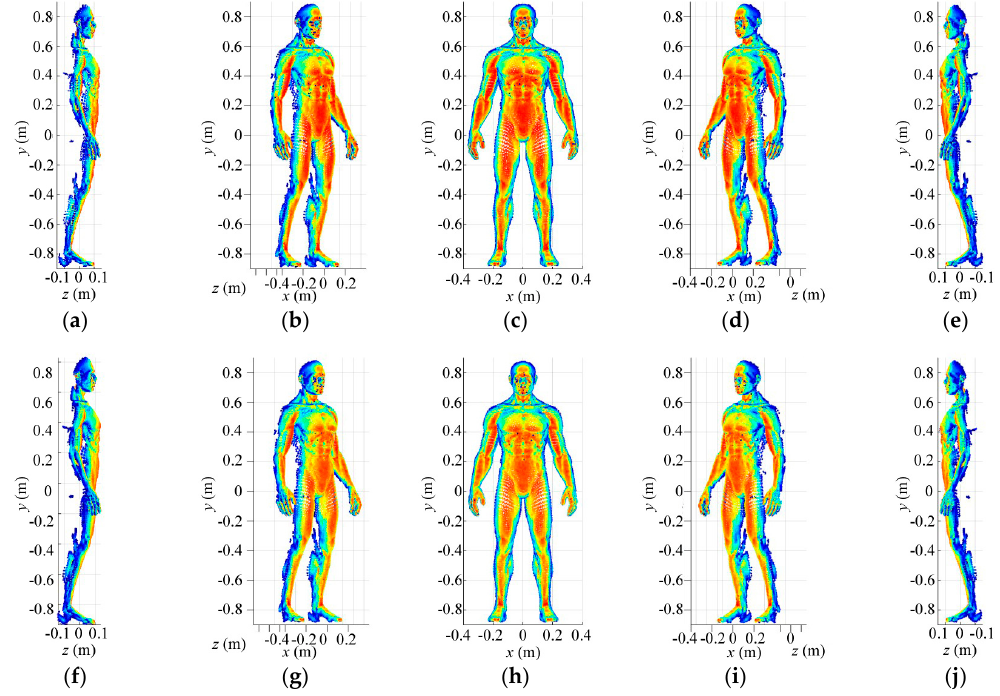
Figure 13. ( a – e ) Imaging results at high-resolution level for SIMO architecture in different perspectives; ( f – j ) Imaging results at high-resolution level for SISO architecture in different perspectives.